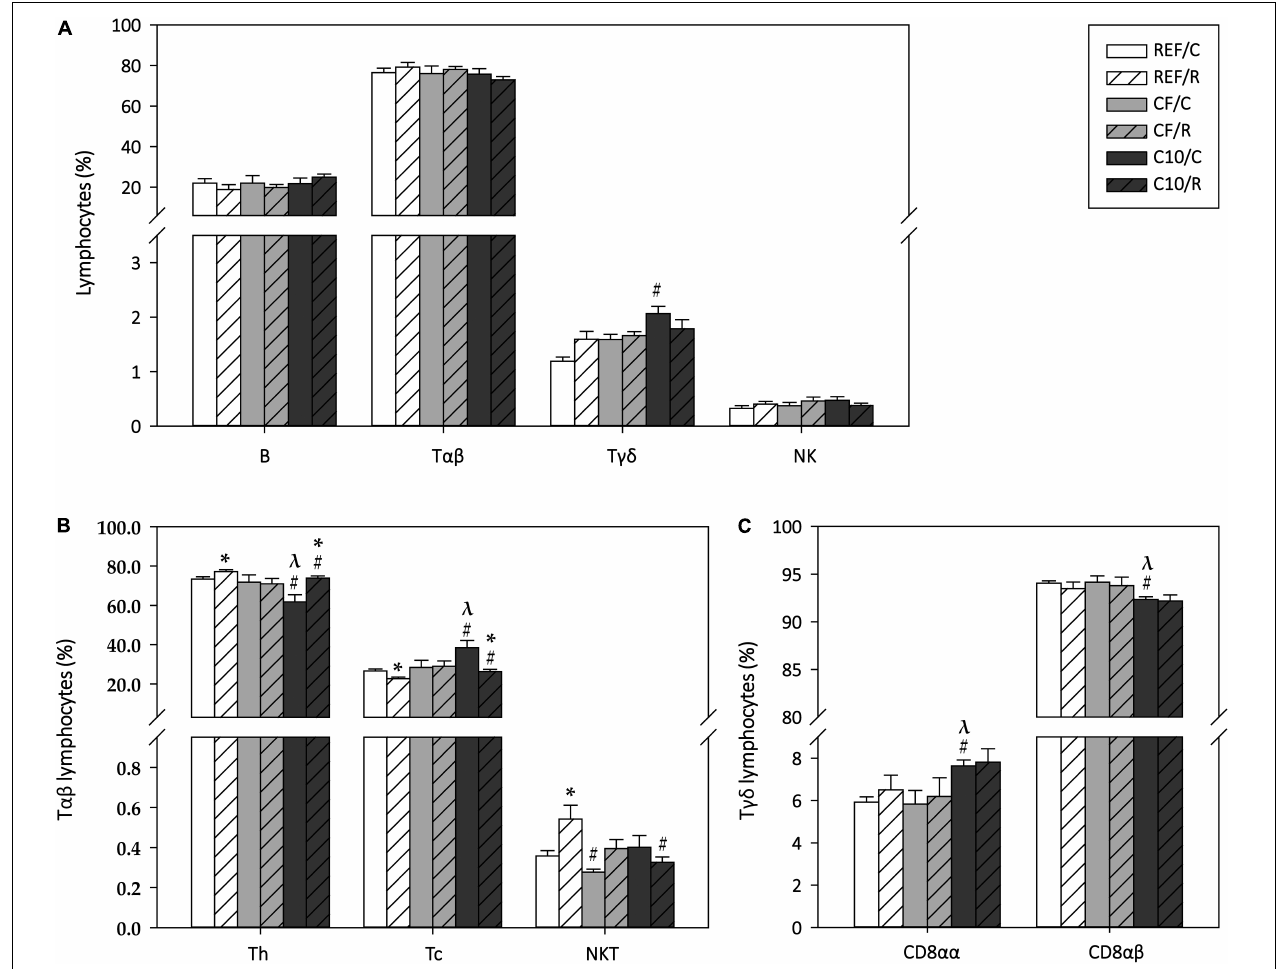
FIGURE 7 | Mesenteric lymph node lymphocytes composition: proportion of main lymphocyte subsets (A) , T αβ cell subsets (B) and T γδ cell subsets (C) . The control (C) groups are represented by smooth bars and the runner (R) groups by striped bars. REF, reference diet; CF, 5% cocoa fiber-enriched diet; C10, 10% cocoa-enriched diet. Data are expressed as mean ± SEM ( n = 8). Statistical differences (Kruskal-Wallis followed by Dunnet’s test): * p < 0.05 vs. the C group in the same diet; # p < 0.05 vs. the same exercise condition in the REF diet; λ p < 0.05 vs. the same exercise condition in the CF